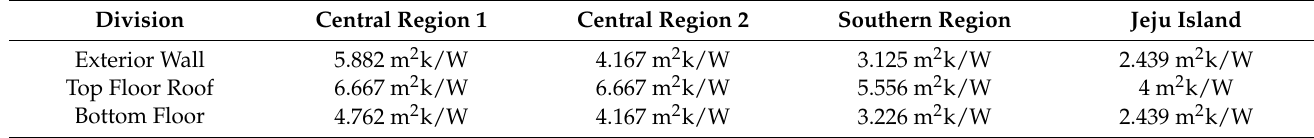
Table 8. Heat resistance standard of each